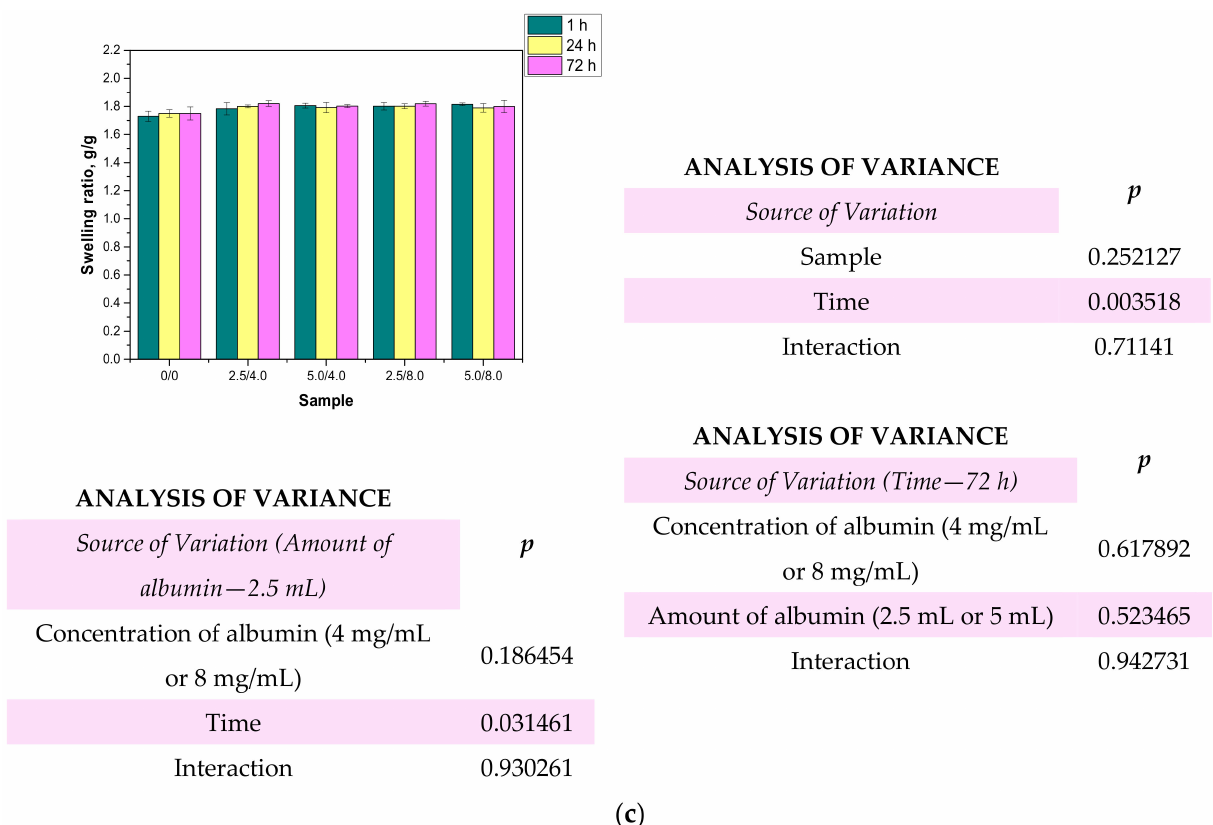
Figure 10. Results of swelling studies performed in distilled water ( a ), SBF ( b ), and Ringer liquid ( c ) (n—number of repetitions, n = 3; p indicates the statistical significance calculated using the two-way analysis of variance